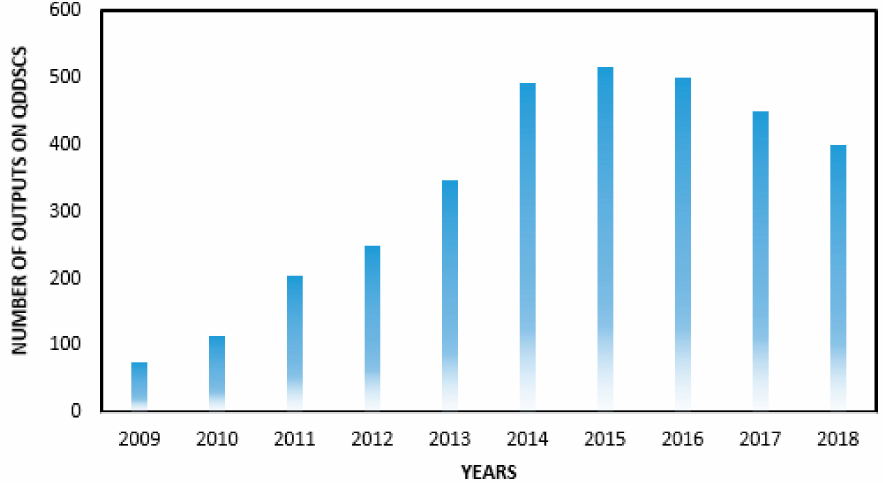
Figure 1. Research outputs from 2009 to 2018 on quantum dot sensitized solar cells (QDSSCs) (reproduced from ref. [6] with permission from the American Chemical